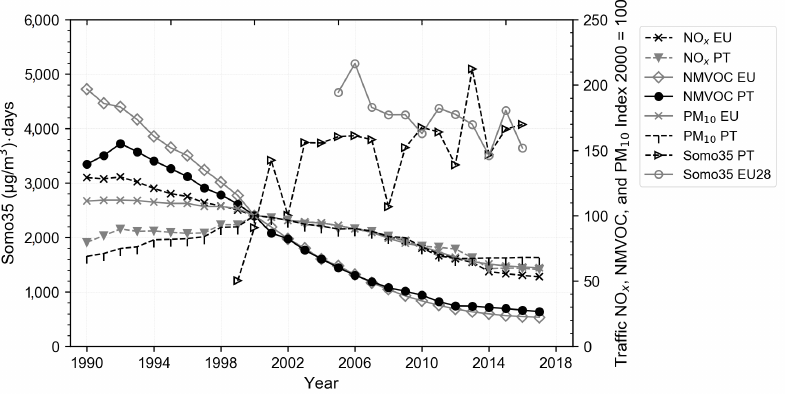
Figure 4. Traffic related NO x , NMVOC and PM 10 trend versus O 3 SOMO35 indicator.